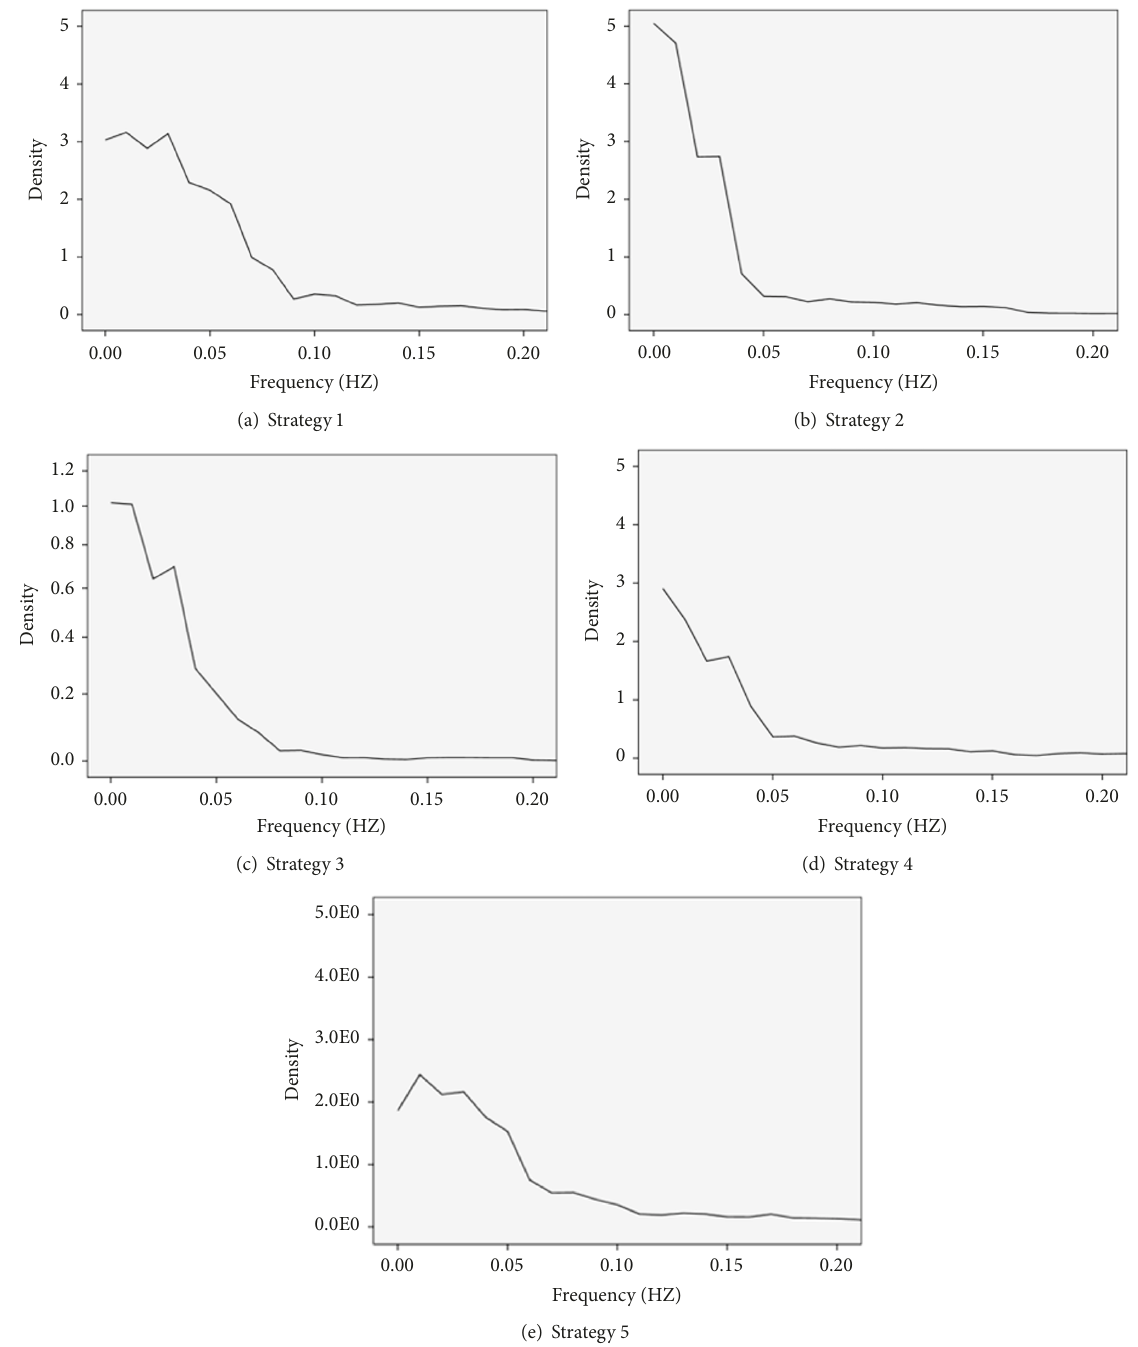
Figure 10: Frequency spectra of the driver’s lateral placement